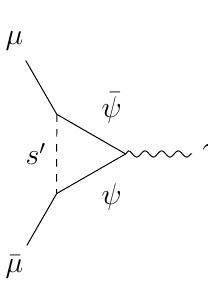
Figure 3 . The one-loop contribution to muon anomalous magnetic moment through the VLL ψ , Figure 5: The one-loop contribution to muon anomalous magnetic moment and the scalon s 0 . through the VLL , and the scalon .